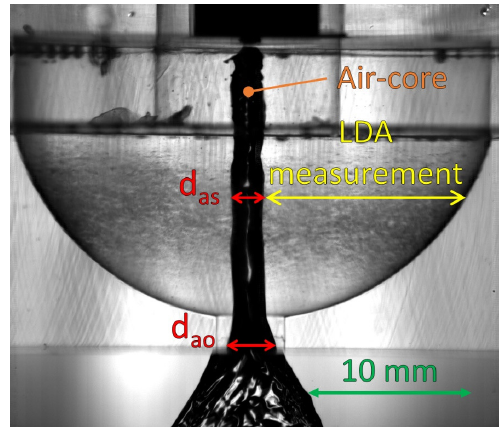
Fig. 2. High-speed visualization with LDA measurement axis .